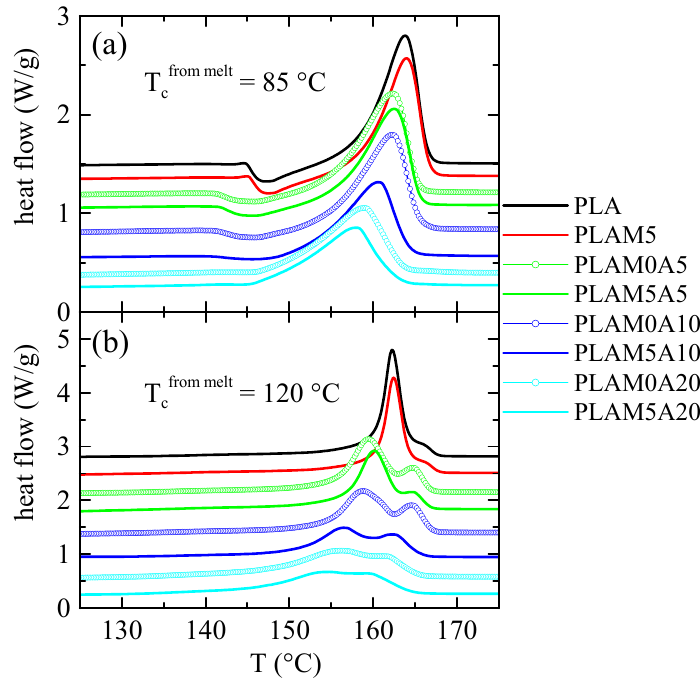
Figure 10. DSC melting curves (endo up) at 10 °C/min for the different samples after crystallization from the melt at ( a ) T c = 85 °C, and ( b ) 120 °C.